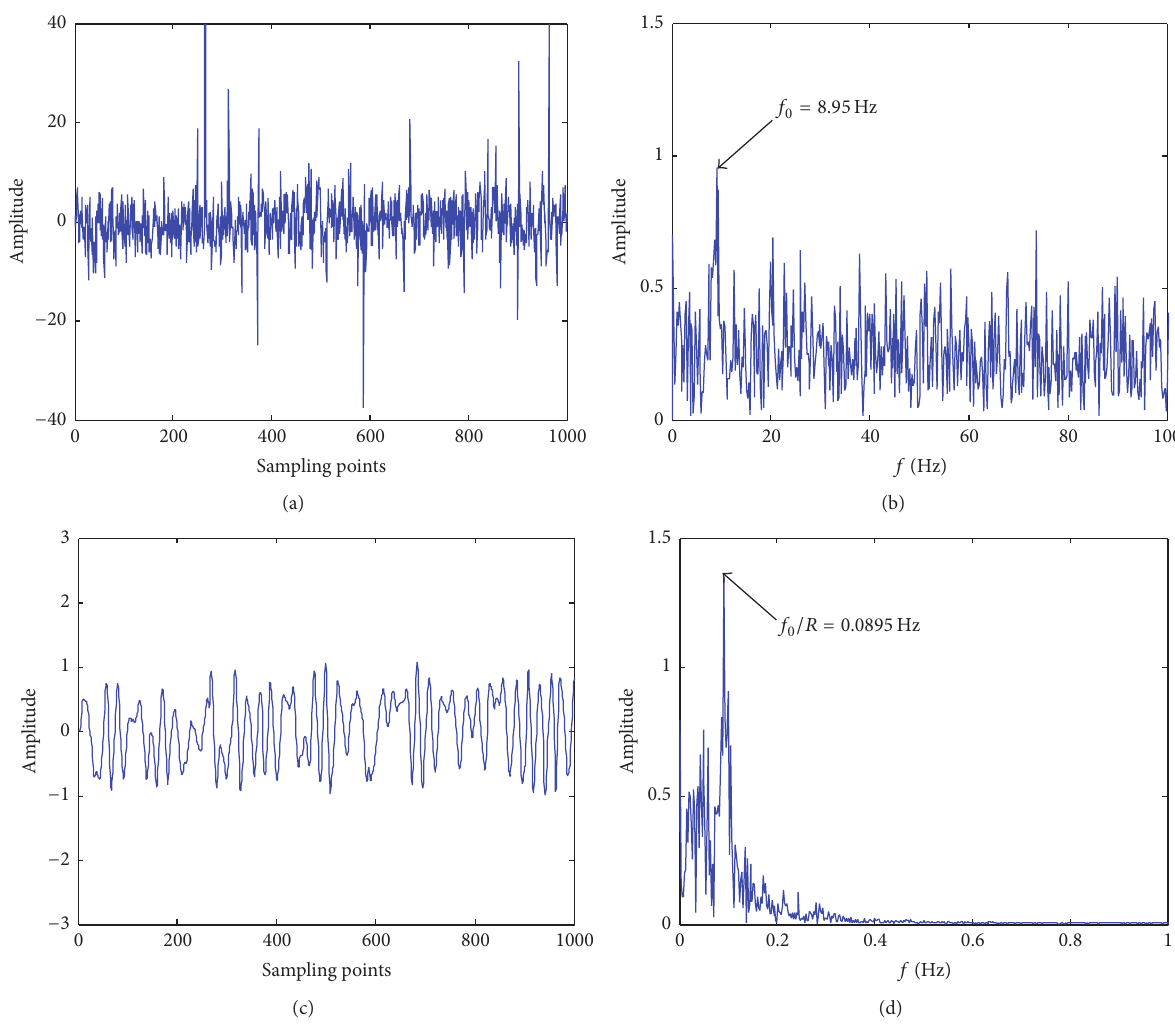
Figure 17: Fault diagnosis result with the proposed method in heavy wear of floating tile. (a) Time-domain waveform of selected signals, (b) frequency spectrum of selected signals, (c) time-domain waveform of output signals, and (d) frequency spectrum of output signals. The system parameters are set to 𝜀 = 1/10 , 𝑅 = 100 , 𝑎 = 0.31 , 𝑏 = 2.1 , and 𝑘 = 0.27